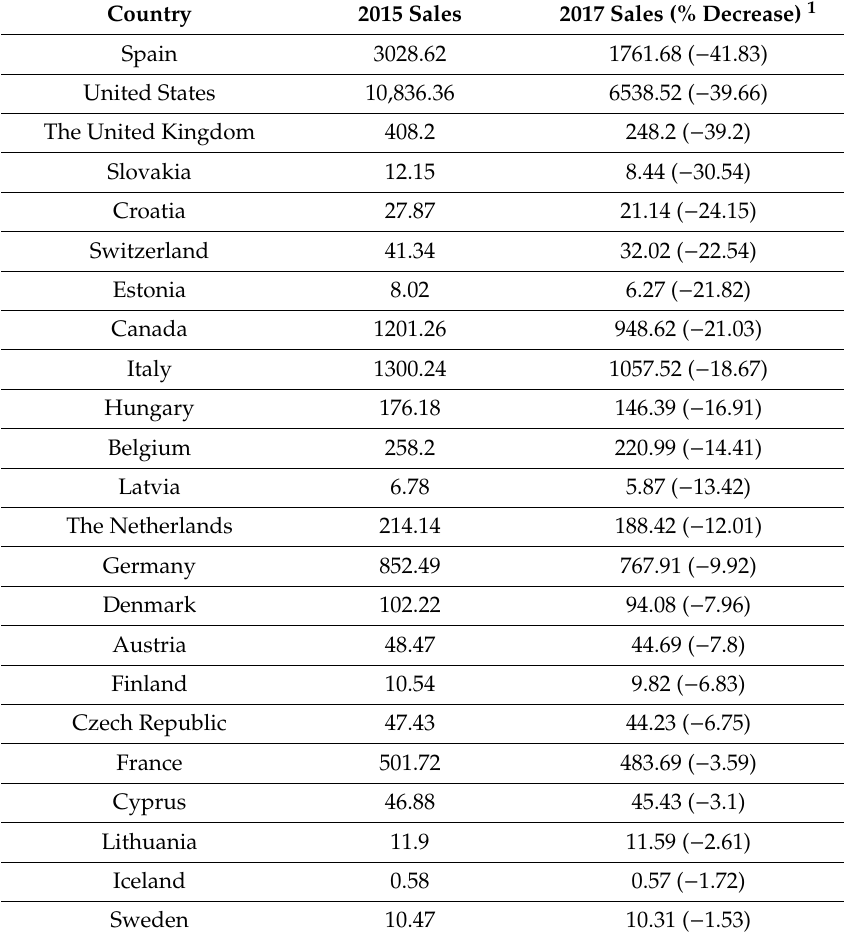
Table 1. High-income countries with a reported decrease in total antimicrobial sales from 2015 to 2017. Sales are reported in